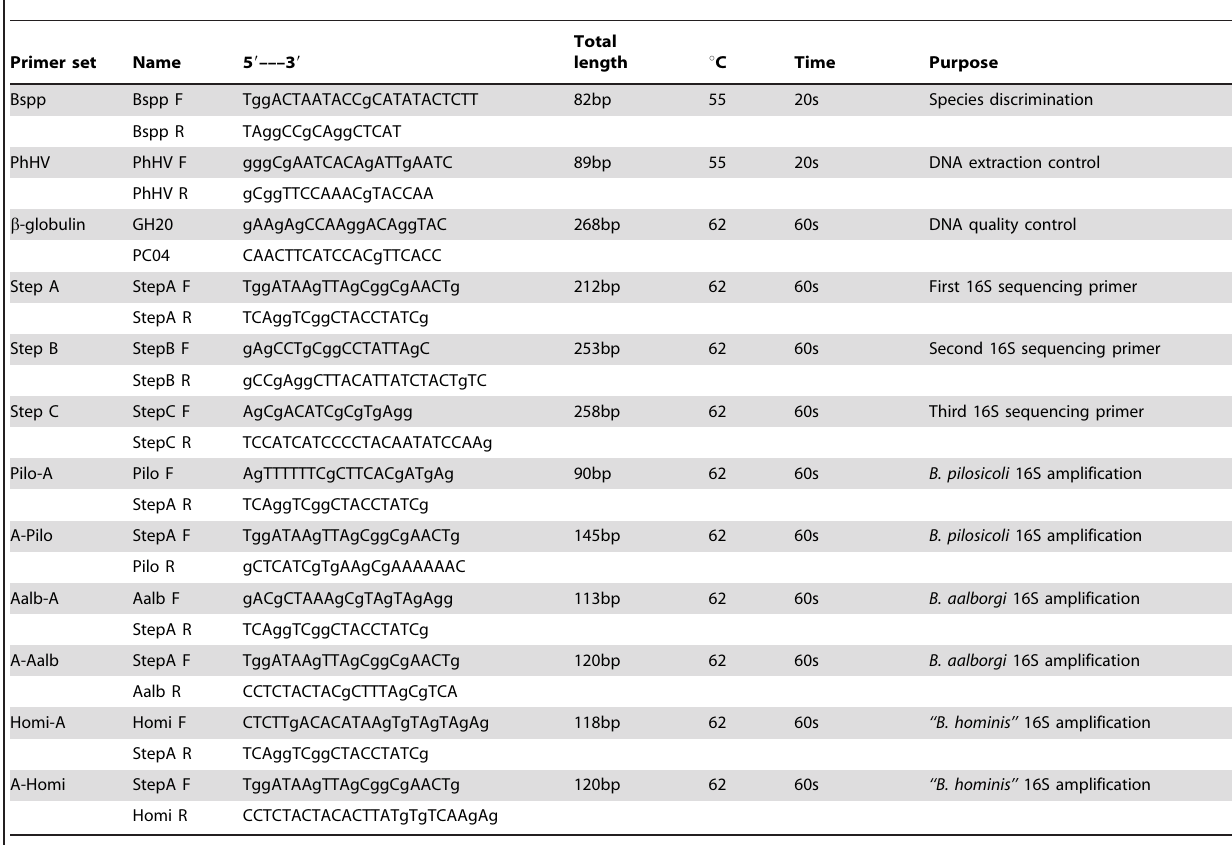
Table 1. Primer sets, length of amplicon, annealing temperature, extension time and PCR-protocol.